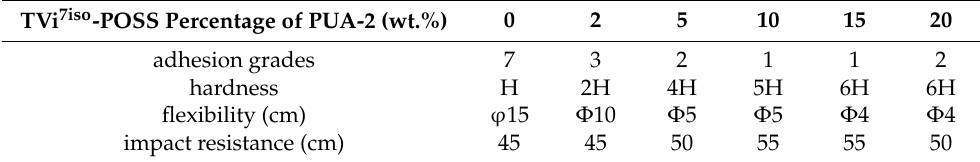
Table 2. Effect of TVi 7iso -POSS content on the mechanical performance of the PFMPUAs coating. TVi 7iso -POSS Percentage of PUA-2